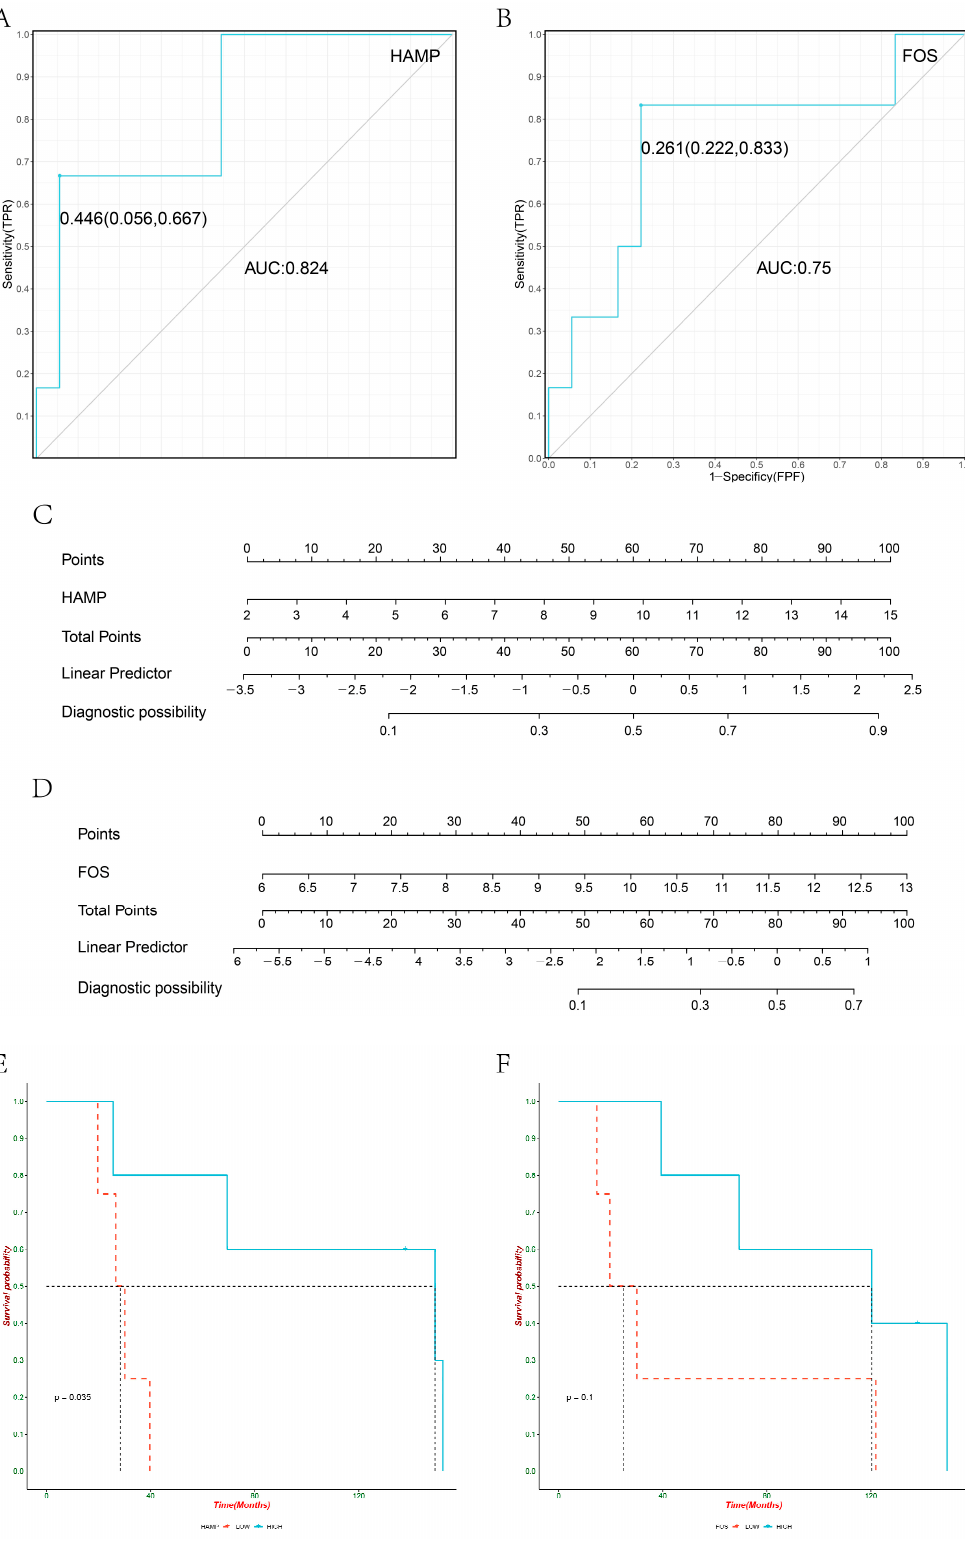
Figure 3. ( A ) ROC curve of HAMP predicting remission in HCC patients treated with PD-1; ( B ) ROC curve of FOS predicting remission in HCC patients treated with PD-1; ( C ) nomogram of HAMP diagnosis in HCC patients treated with PD-1; ( D ) nomogram of FOS diagnosis in HCC patients treated with PD-1; ( E ) KM curve of prognostic HAMP in HCC patients treated with PD-1; ( F ) KM curve of prognostic FOS in HCC patients treated by PD-1.